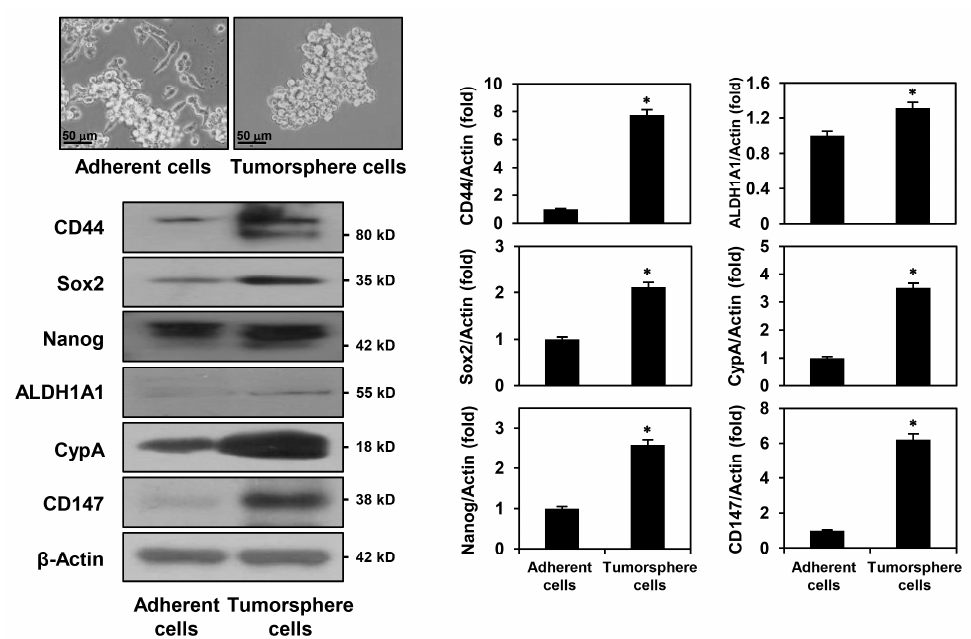
Figure 2. Expression levels of key gastric cancer stem cell (GCSC) markers, CypA, and CD147 in MKN45 adherent and tumorsphere cells. Protein levels were detected via Western blot analysis using specific antibodies and were further quantified using densitometry. β -actin levels were used as an internal control. The ratio of each target protein to β -actin for adherent cells was normalized to onefold. * p < 0.05 vs. the adherent cells.